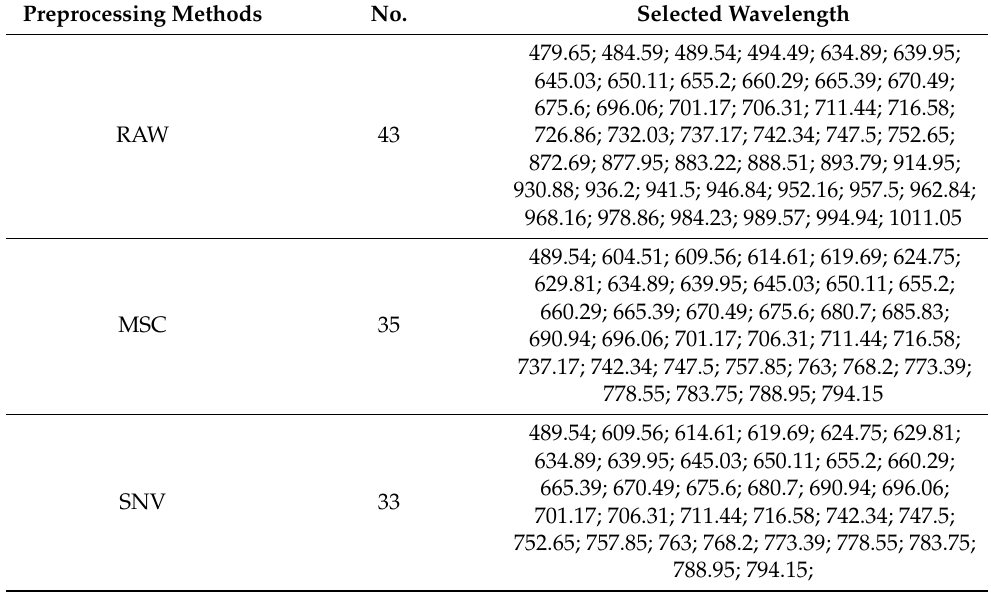
Table 2. The wavelengths selected for VIP > 1 in PLS–DA.